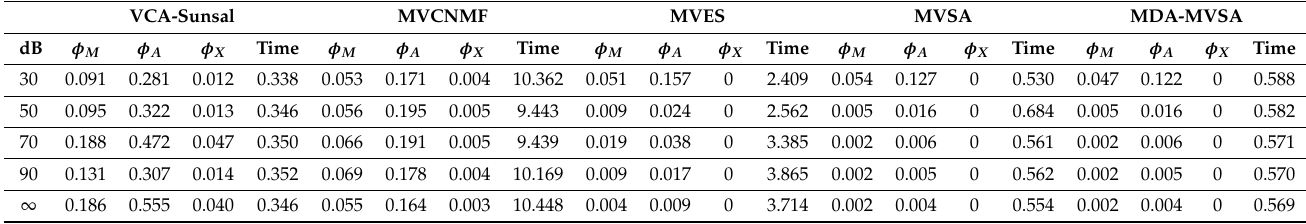
Table 2. Performance and processing time (seconds) for different endmember extraction algorithms on synthetic data with 2000 pixel points and five endmembers and containing pure mineral signatures for the United States Geological Survey (USGS) library under different noise levels.